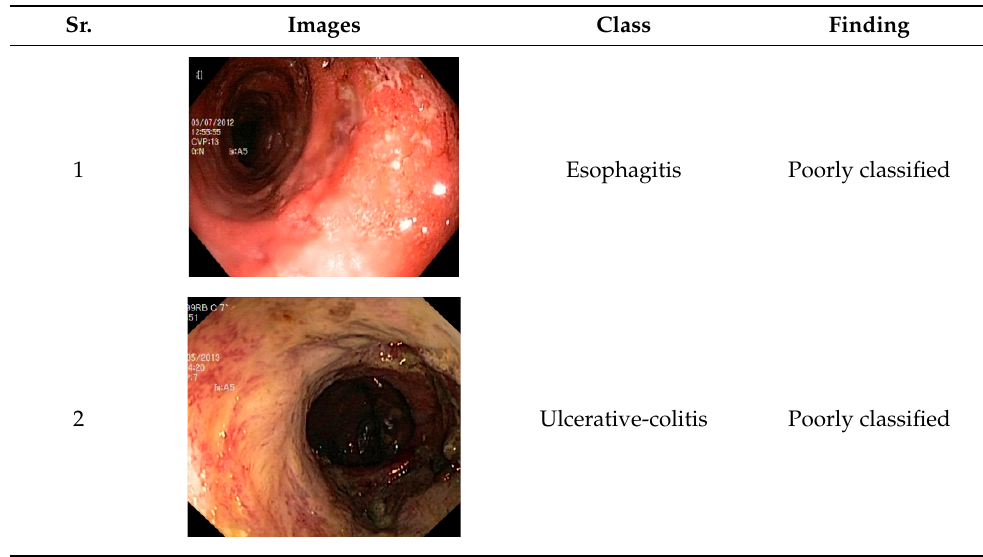
Table 7. Confusion matrix of our proposed model (Mobilenetv2).